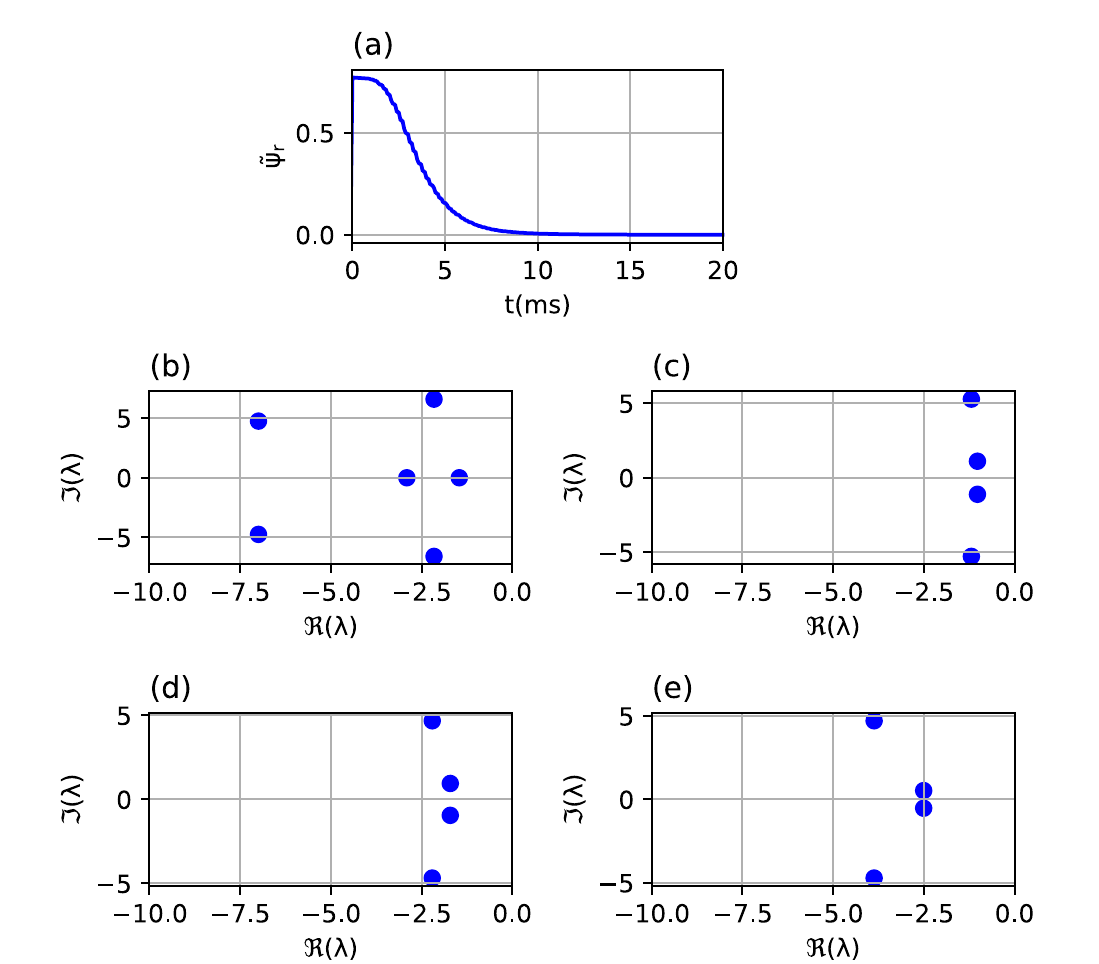
Figure 7. Sampling time influence on observer dynamics identification for order of the identified system n = 4: ( a ) impulse response of the system, ( b ) poles of the linearized system, ( c ) poles of an identified system based on signal with T s = 20 µ s, ( d ) poles of an identified system based on signal with T s = 150 µ s, ( e ) poles of an identified system based on signal with T s = 500 µ s.